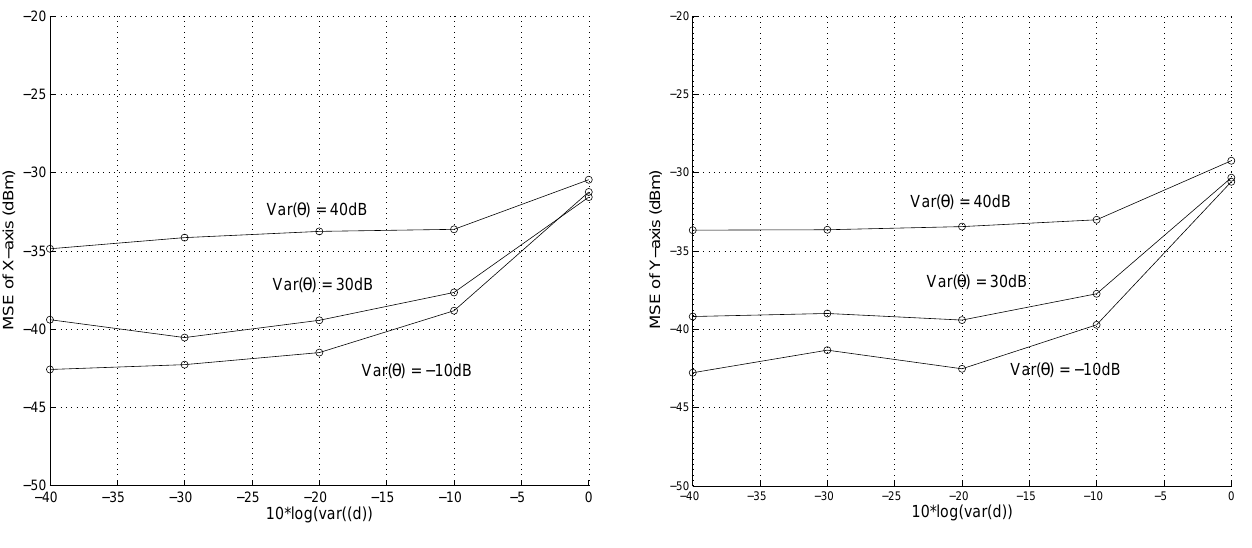
Figure 10. The effect of uncertainty of angle estimation on position estimation accuracy.